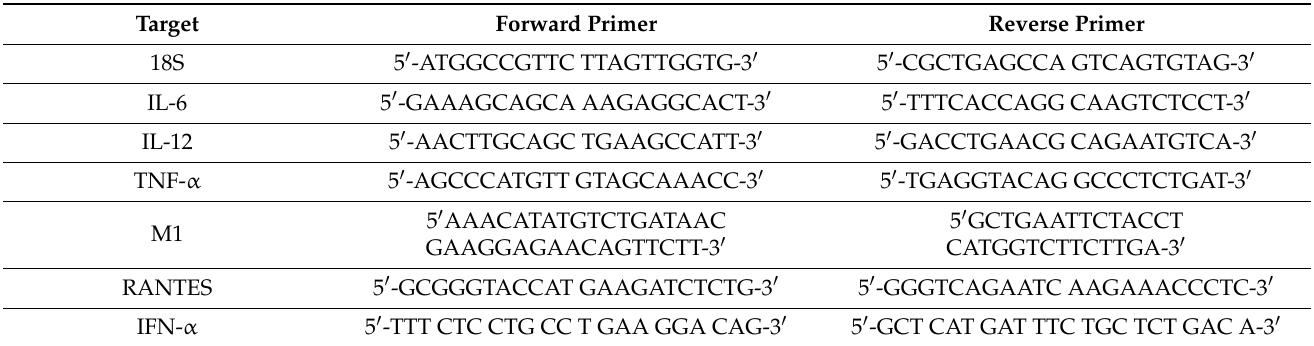
Table 2. Forward and reverse primers used for qRT-PCR.